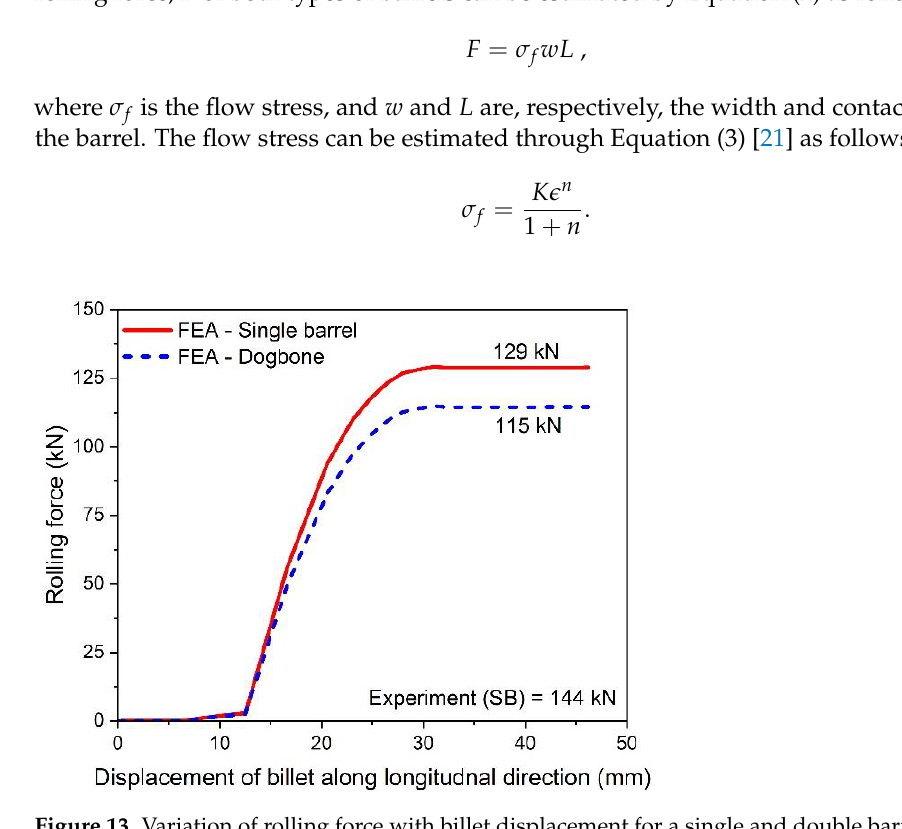
Figure 12. Equivalent plastic strain distribution on the deformed strip after strip deformation by stand 14. ( a ) Strip deformed by grooved rolls, ( b ) strip deformed by grooveless rolls.